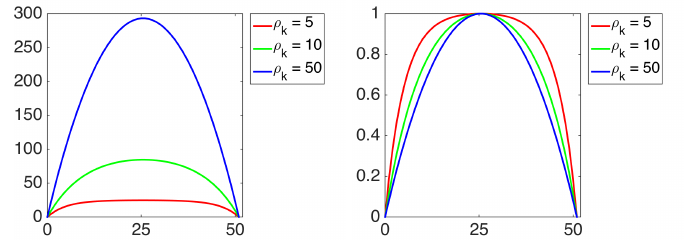
Figure 1. Features computed for a one-dimensional signal using three different values of the parameter ρ k ( left ) and normalized features ( right